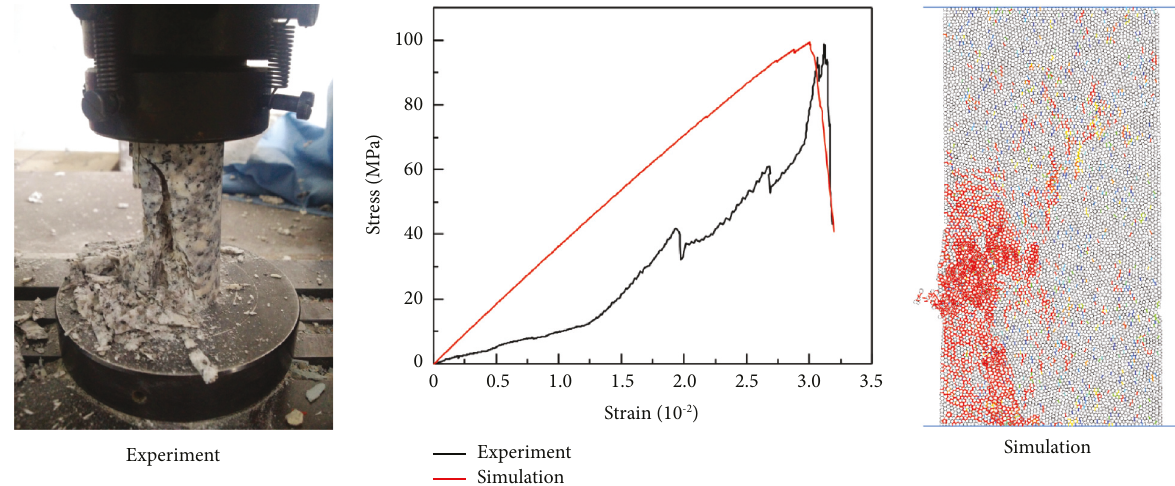
Figure 9: Uniaxial compression results of experiments and numerical simulations.